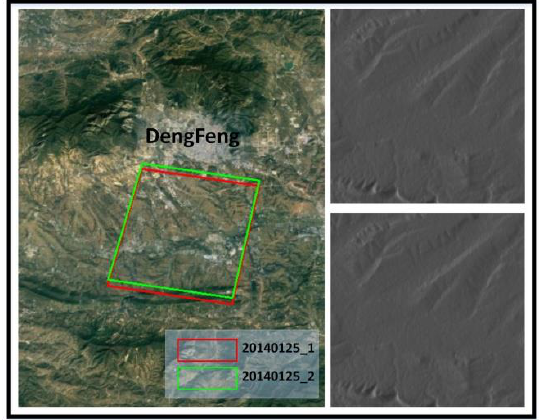
Figure 1. Study area and image range.